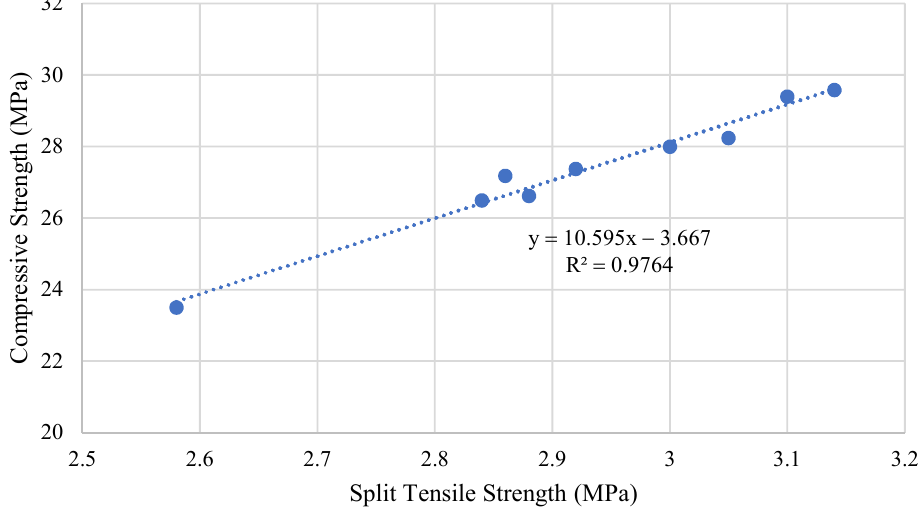
Figure 14. Correlations between the splitting tensile strength and compressive strength of concrete containing CCA and GGBFS alone.